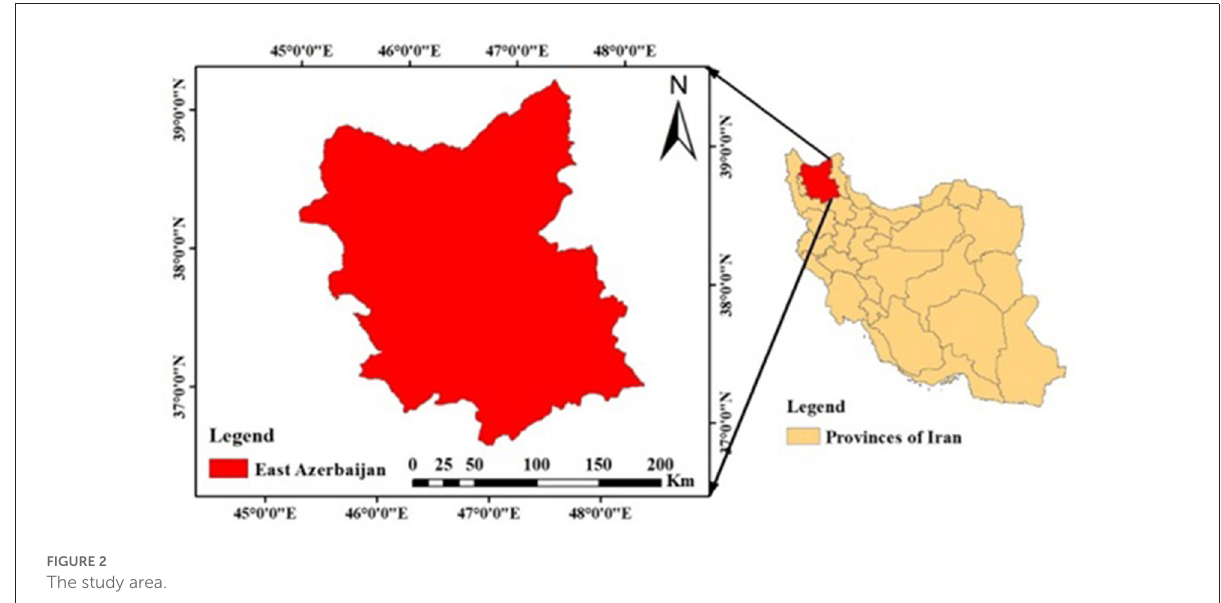
FIGURE2 The study